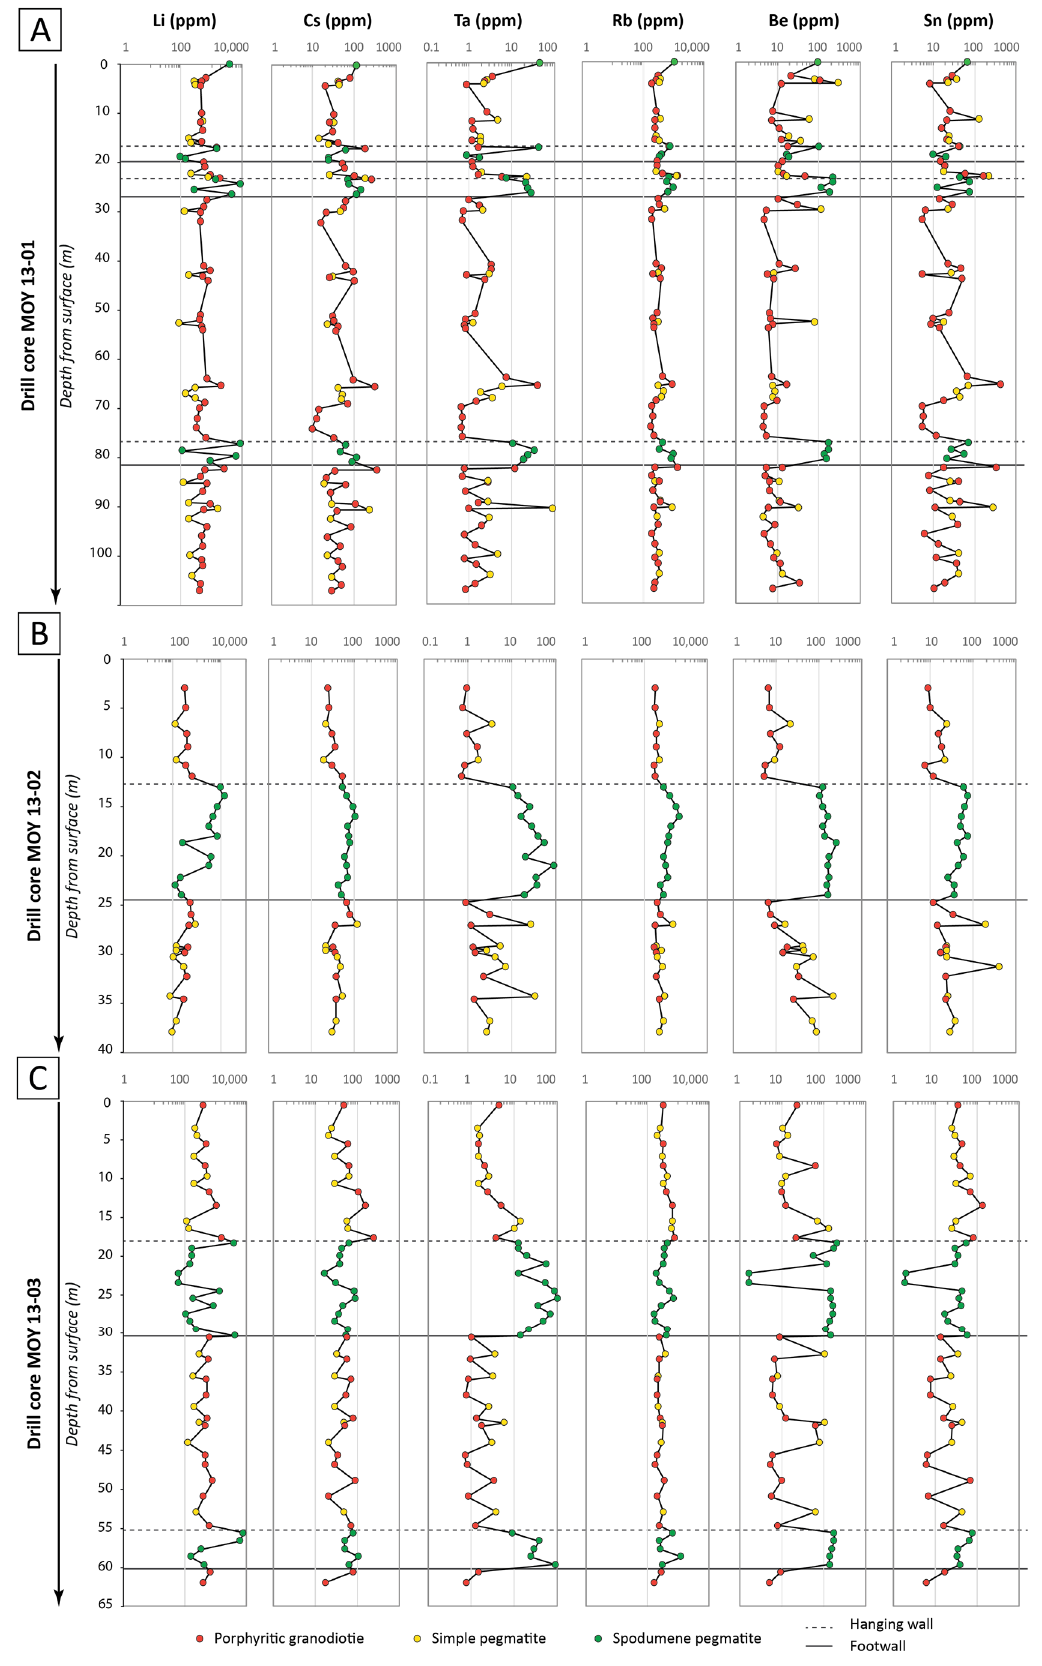
Figure 9. Geochemical profiles for Moylisha drill cores ( A ) MOY 13-01, ( B ) MOY 13-03 and ( C ) MOY 13-03. Drill holes intercepted pegmatites at ~90°.